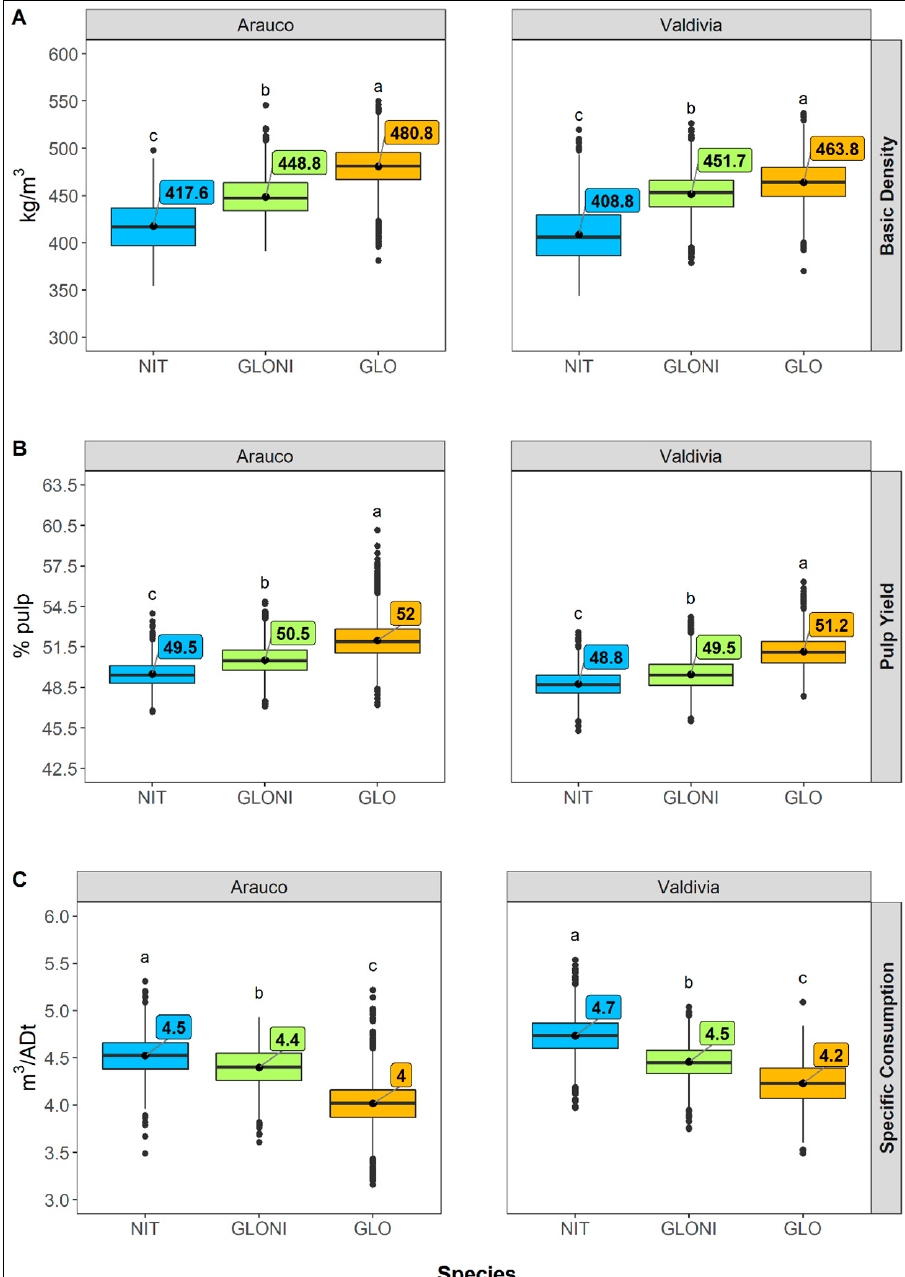
Figure 4. Means for parental and hybrid wood properties in Arauco and Valdivia breeding zones. ( A ) Basic Density (kg/m 3 ). ( B ) Pulp Yield (%). ( C ) Specific Consumption (m 3 /ADt). The abbreviation NIT is for E. nitens , GLO for E. globulus , and GLONI is for the hybrid between these species. The NIT and GLO wood property values were obtained from the company’s current pure species breeding programs (around 5–8 tests for each zone). The Tukey HSD significance test for differences in the means of Basic Density (kg/m 3 ), Pulp Yield (%), and Specific Consumption (m 3 /ADt) was performed within zone, where different letters indicate statistically significant differences ( p <